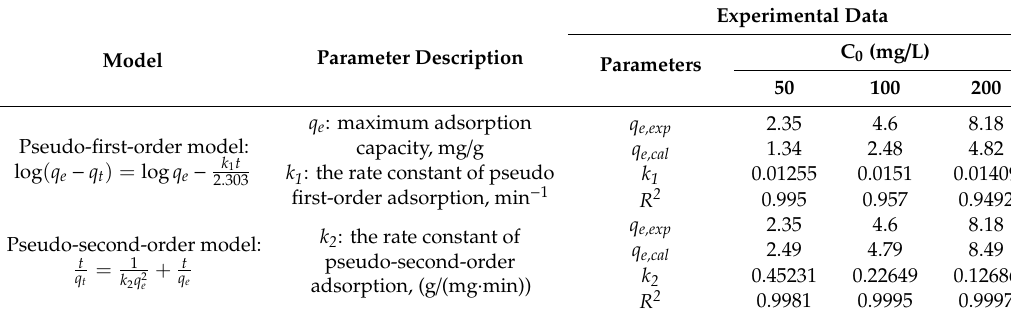
Pseudo-second-order model: